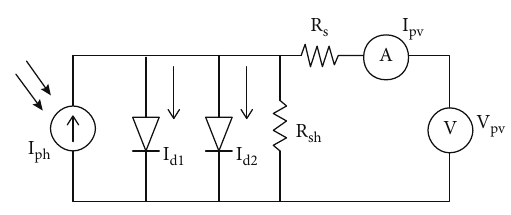
Figure 4: Circuit of equivalence –